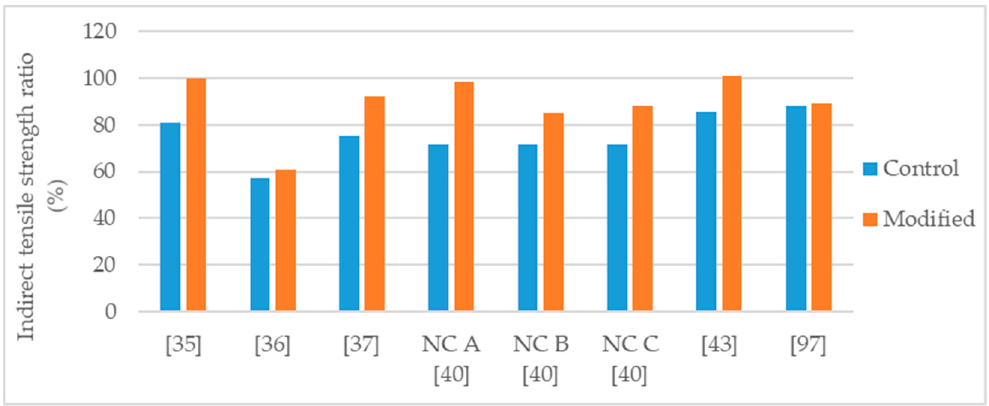
Figure 9. Indirect tensile strength ratio of control and nanoclay modified asphalt mixtures.